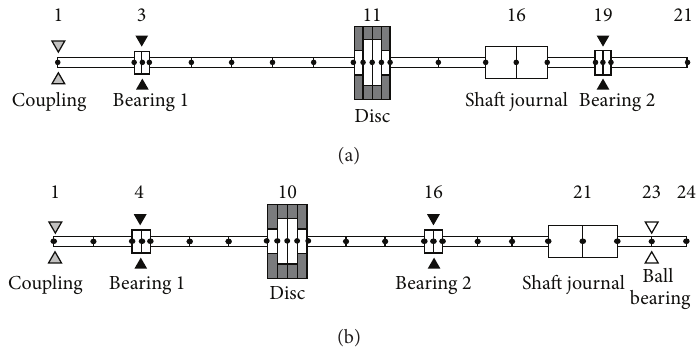
Figure 1: Finite element models: (a) configuration A; (b) configuration B.